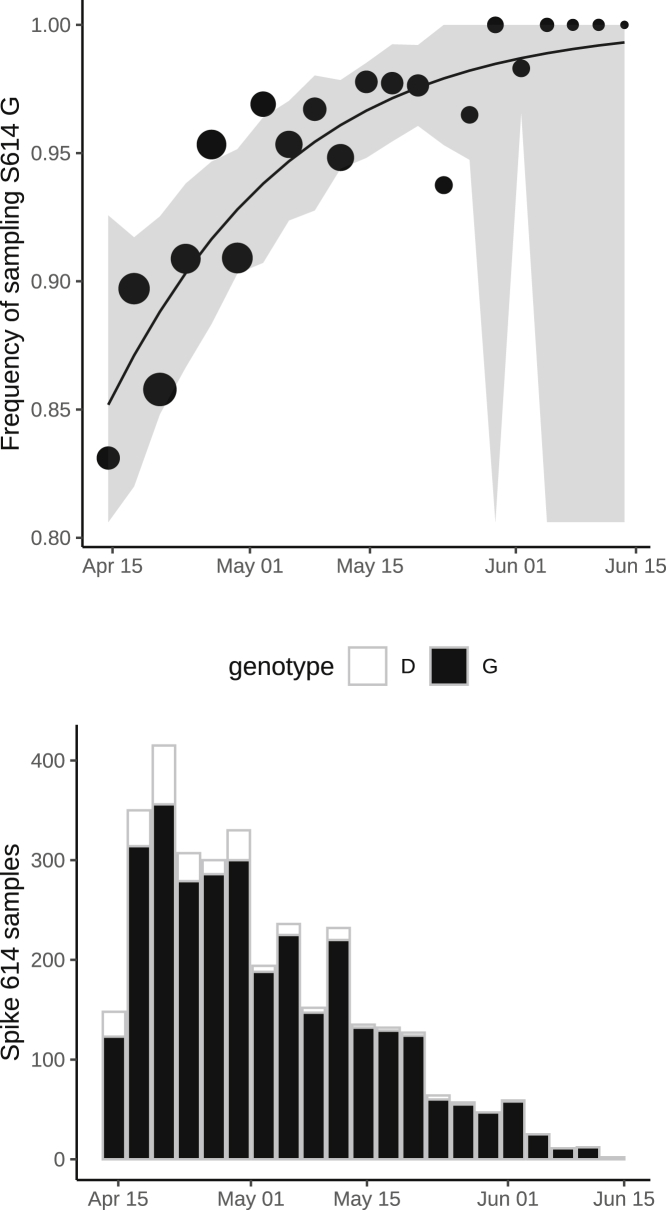
Frequency of Sampling Spike 614G after April 15, Related to Figure 3This shows frequency and numbers of Spike 614G and Spike 614D samples over time using 37 DT clusters detected before March 31, 2020. The size of points represents the number of samples collected on each day. The line and shaded region showed the MLE and confidence interval fit of the logistic growth model.